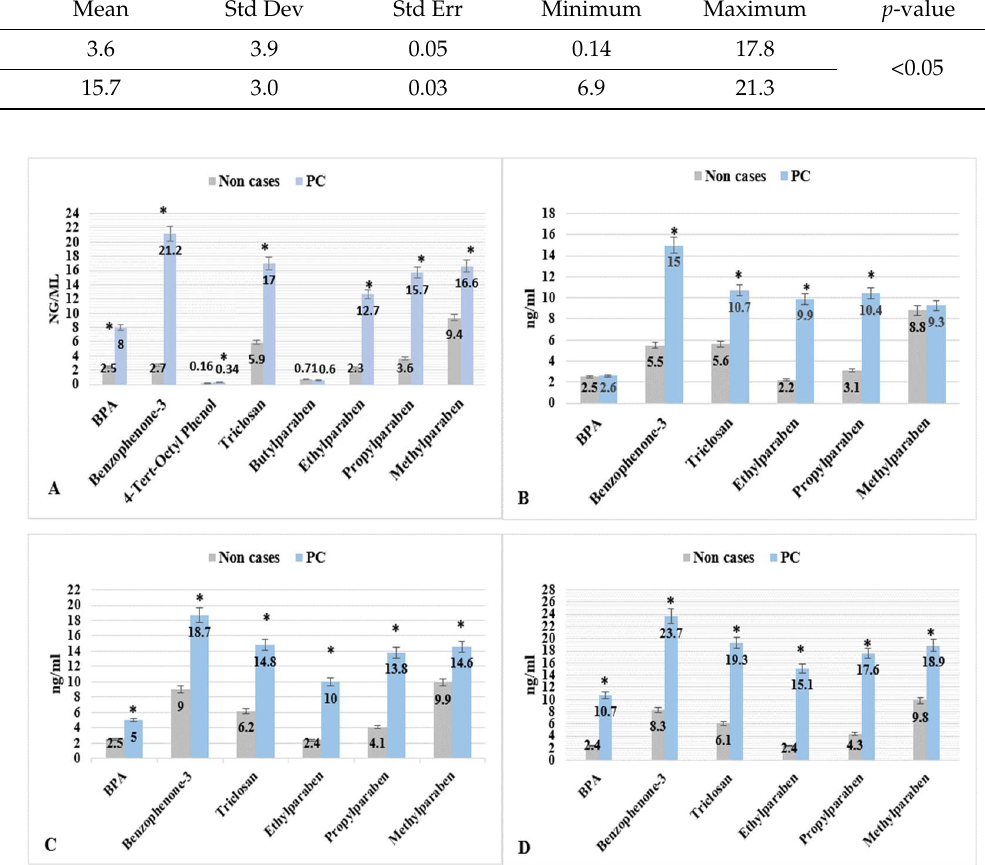
Figure 1. EPs & PBs levels (mean, ng/mL) by PCa for men with concentrations ≥ LOD; NHANES